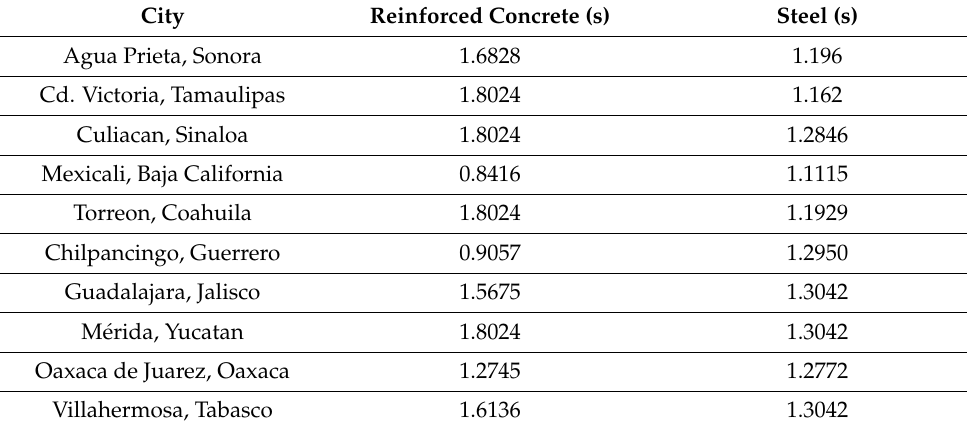
Figure 3. ( a ) Plan, ( b ) Elevation. Structural configurations of the reinforced concrete and steel buildings. Table 1. Period of vibration of buildings.